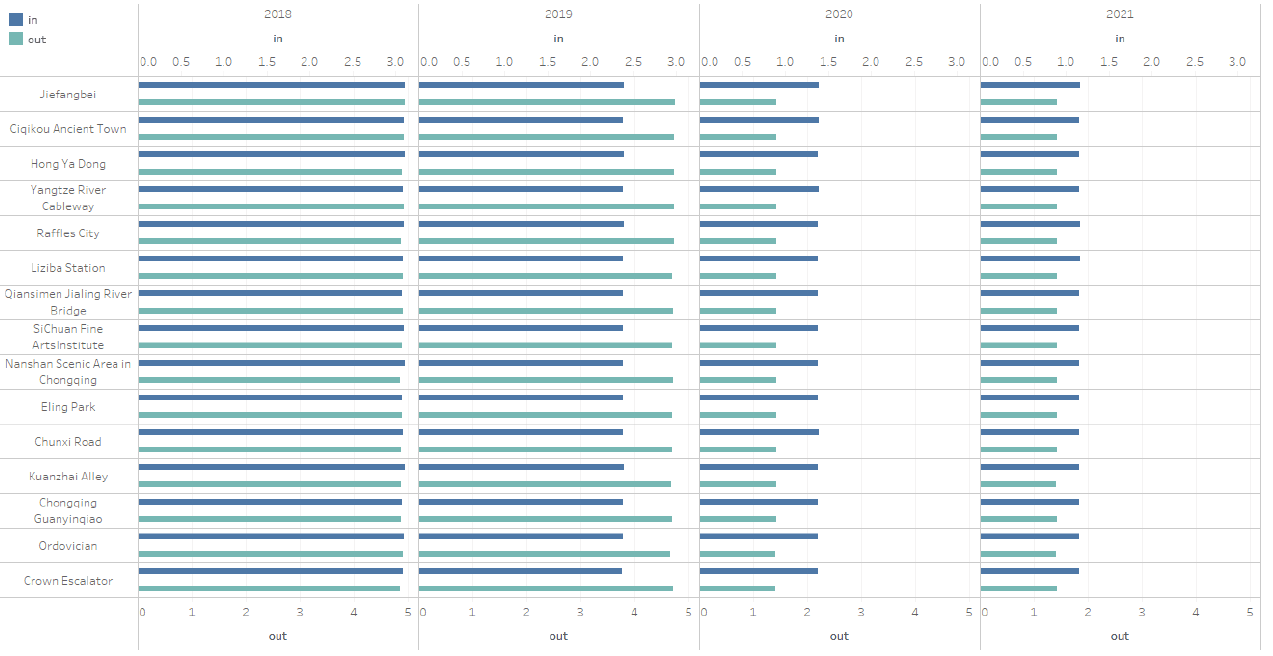
Figure 6. Closeness centrality value of tourist attractions in the Chengdu–Chongqing Economic Cir- cle in 2018–2021. Circle in